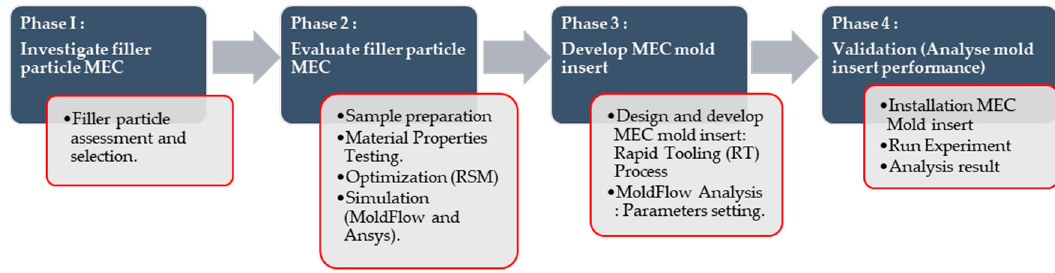
Figure 2. Flow chart.